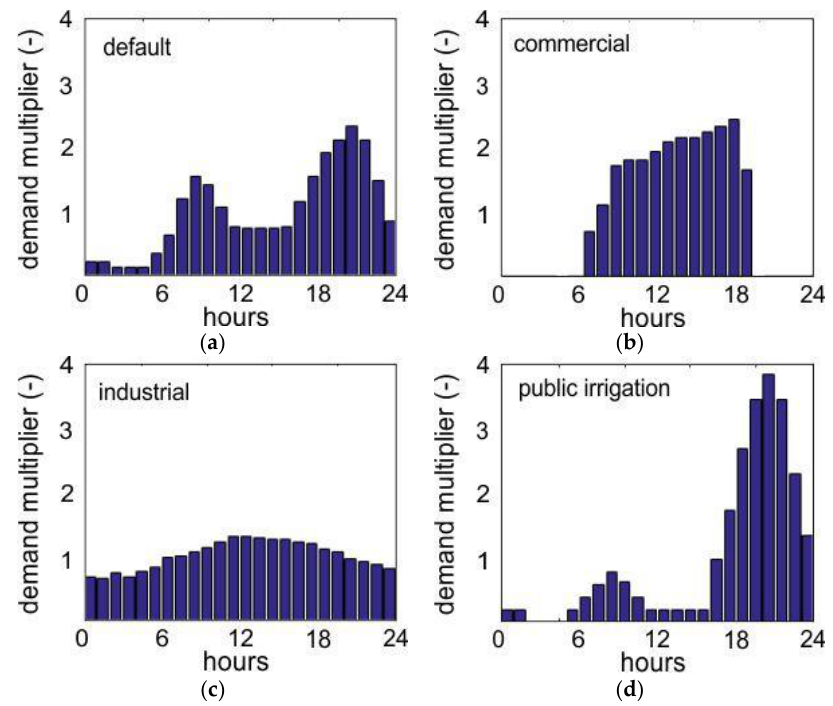
Figure 2. Diurnal design demand patterns used for the Case Clyde model: ( a ) default (domestic) indoor pattern; ( b ) commercial pattern; ( c ) industrial pattern; ( d ) (public and private) outdoor irrigation pattern. In the hydraulic model the average daily demand is used for the demand nodes. In addition these patterns are applied as hourly demand multipliers for the average daily demand.